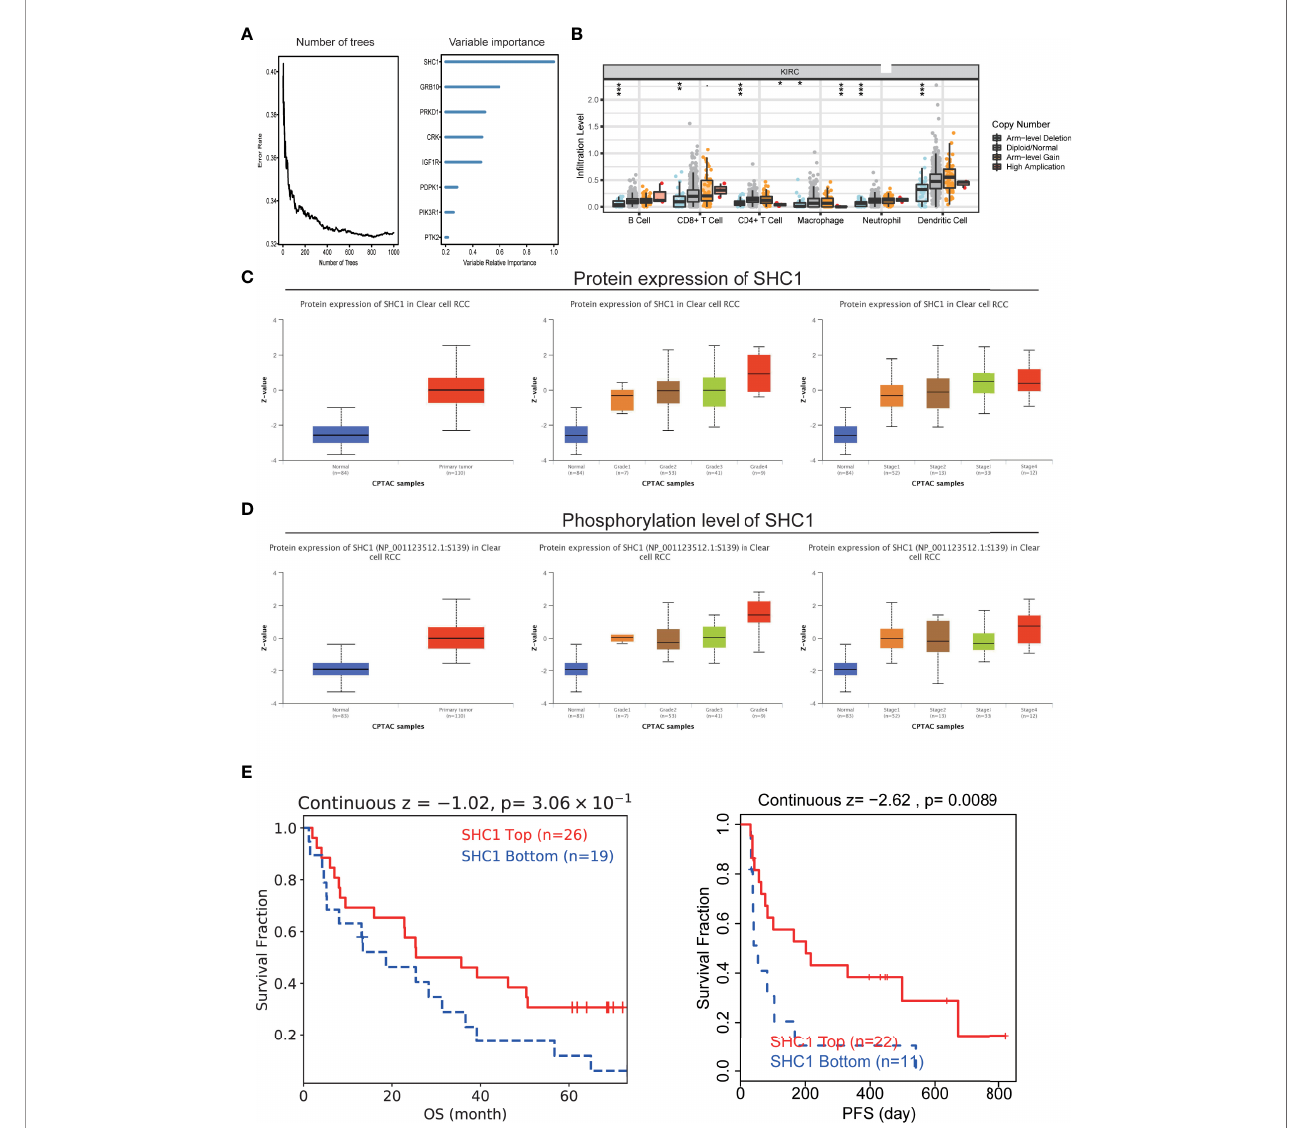
FIGURE 11 | The hub role of SHC1 in ccRCC. (A) Number of trees showing the importance proportion of IGF regulator genes. (B) The association between SHC1 mutation and immune cell in fi ltration in ccRCC. (C) Protein levels of SHC1 in ccRCC samples, classi fi ed by tumor grade, and histological pathological stage using the UALCAN database. (D) Phosphorylation level of SHC1 in ccRCC samples, classi fi ed by tumor grade, and histological pathological stage. (E) The relationship between SHC1 expression and immunotherapy